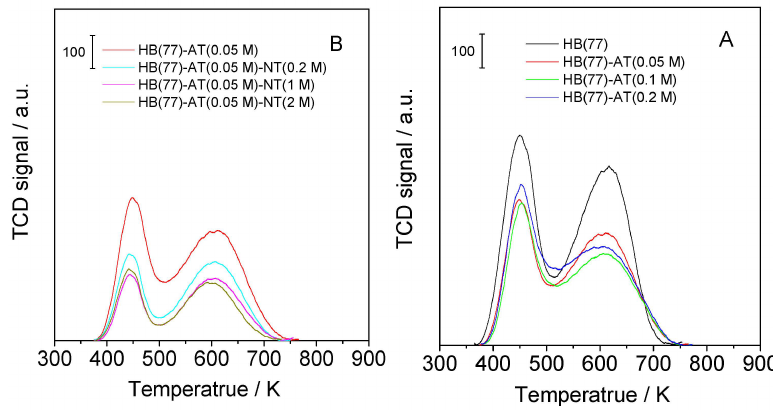
Figure 7. NH 3 -TPD profiles of HB(77), alkali-treated HB ( A ); and alkali-acid-treated HB ( B )